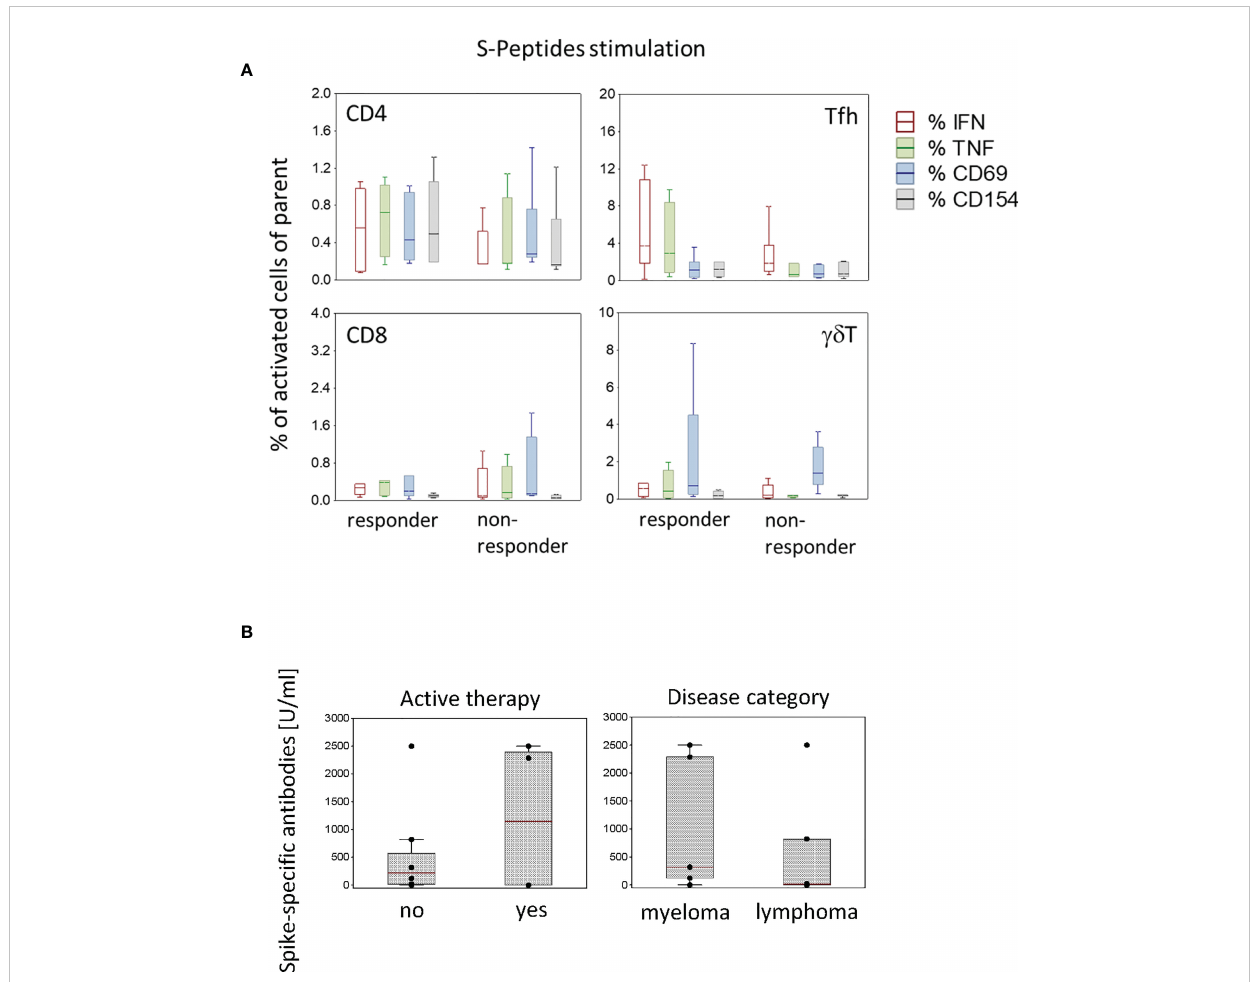
FIGURE 5 Activated T cell subtypes in antibody responder (N=6) and non-responder (N=6) patients (A) and spike-speci fi c antibody concentrations in patients (N=12) according to active therapy (no, N=8; yes, N=4) and disease category (myeloma, N=6; lymphoma N=6) (B) after two vaccine doses. Box plots with median, interquartile range and minimum-to-maximum whiskers show the percentages of activated T cell subtypes (A) and the spike-speci fi c antibody concentrations (B) . Data analysis with Mann-Whitney U Test, no signi fi cant differences were